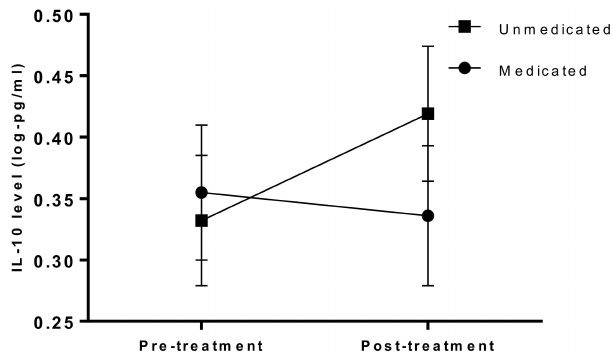
Figure 3. IL-10 changes with treatment; interaction with psychotropic